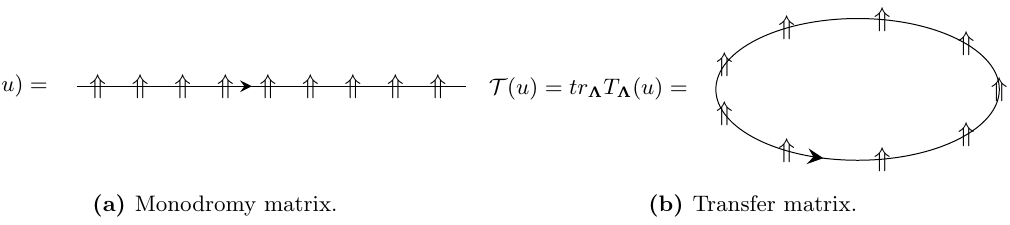
Figure 9. so (6) Monodromy and Transfer matrices with (cid:3) auxiliary space. The spin chain sites represent any of the elementary (cid:12)elds